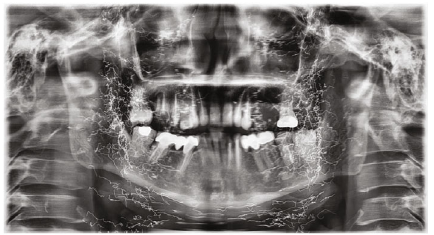
Figure 1: Numerous, short, tortuous, hyperdense threads revealed bilaterally in the maxillofacial